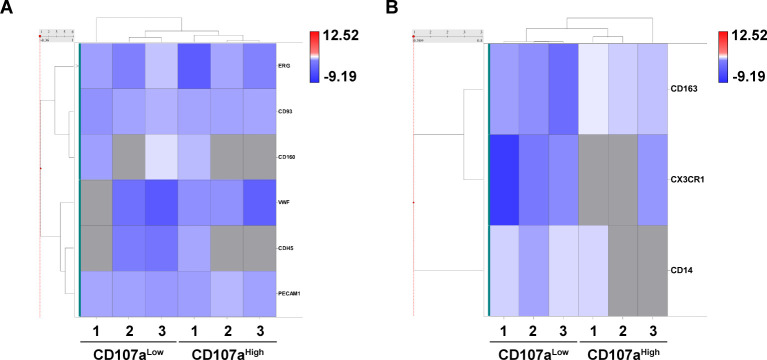
Additional RNA sequencing analysis of CD107alow and CD107ahigh mesenchymal cells.(A,B) Heat map demonstrating mRNA expression levels of endothelial markers (A) and inflammatory markers (B) among CD107alowCD31-CD45- and CD107ahighCD31-CD45- mesenchymal cells.